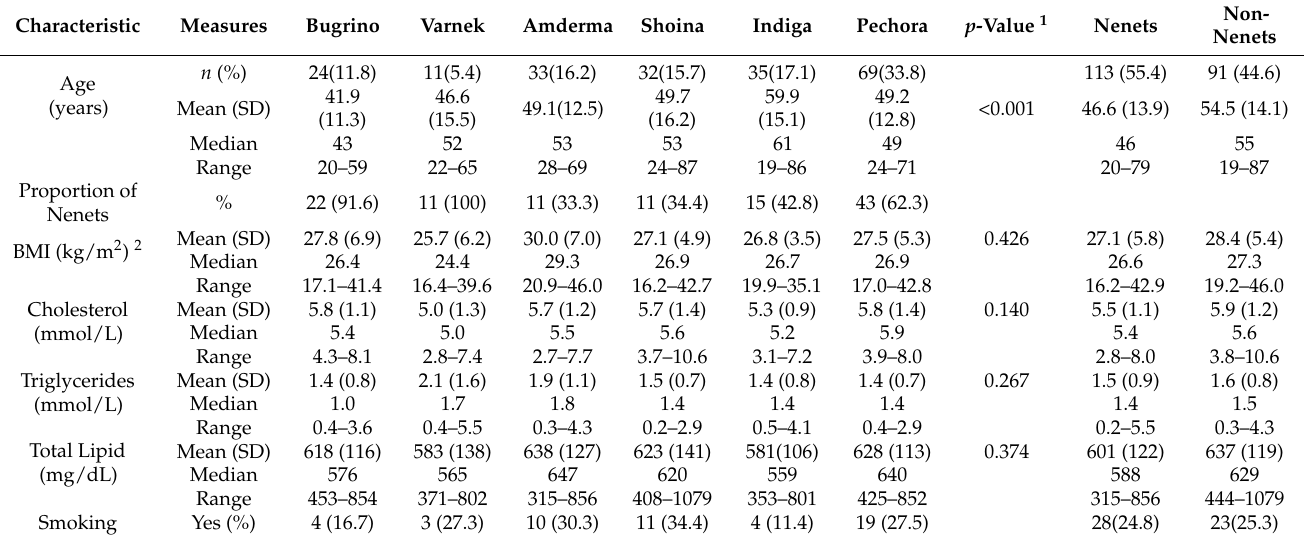
Table 2. Characteristics of the study population: Women in Nenets Autonomous Region.